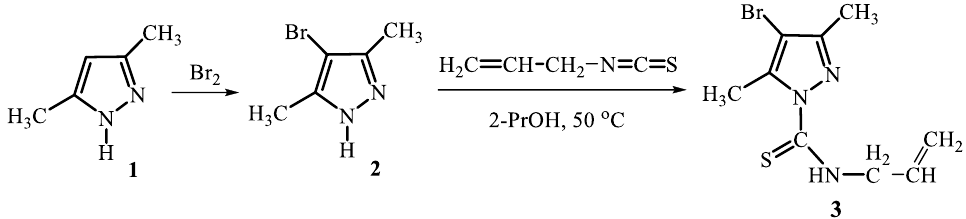
Figure 2. Pharmaceutical preparations containing a pyrazole